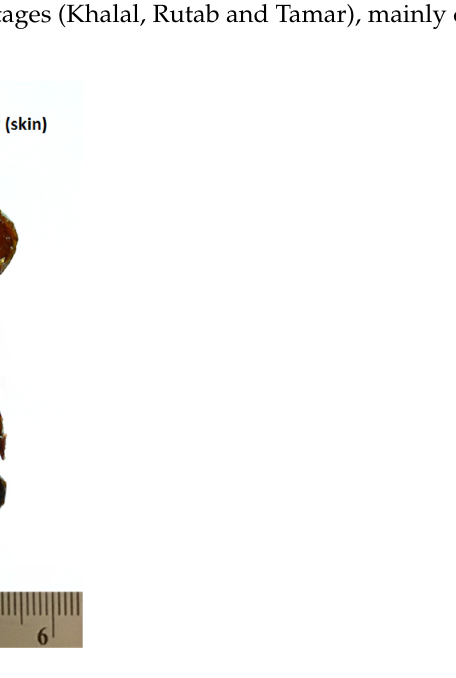
Figure 2. The anatomy of fruit of the date palm ( Phoenix dactylifera L., cv. Confitera ) at late Rutab stage. The Hababouk, initial stage: The period just after pollination when the young fruit is white before gradually turning green in the following stage. This lasts for 1–5 weeks from pollination. At this stage, the fruits are immature. They present between 80–90% moisture content